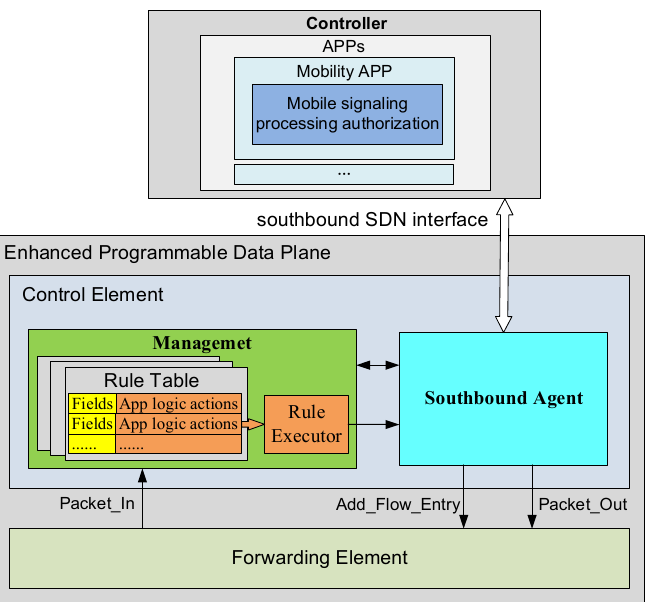
Figure 4. Overview of the control-plane-function offloading mechanism based on the rule table.